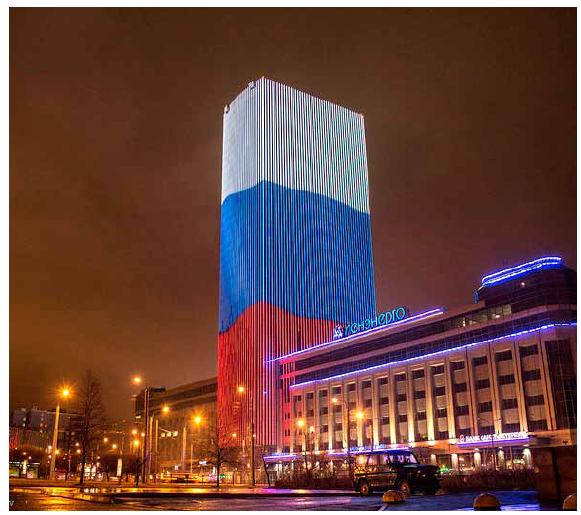
fig. 6. The “leader Tower” is located at a distance from